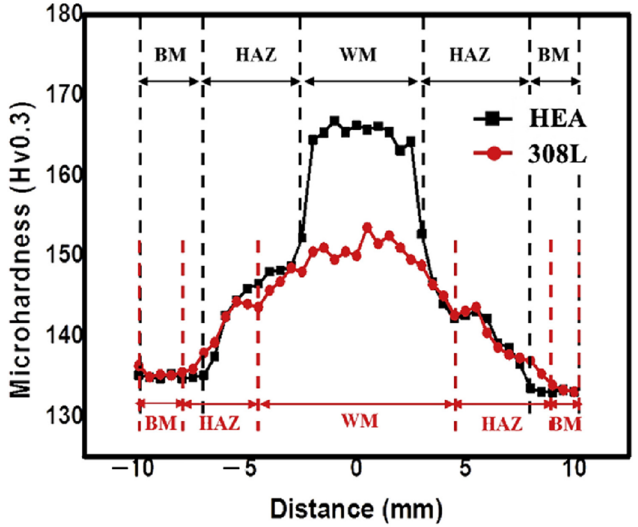
Figure 5. Microhardness distribution across the GTAWed HEA corresponding to STS 308 L and HEA fillers. Reproduced with permission from [80]. Copyright Elsevier, 2020. Table 1. Mechanical properties and microstructural features of fusion welded HEA. Material